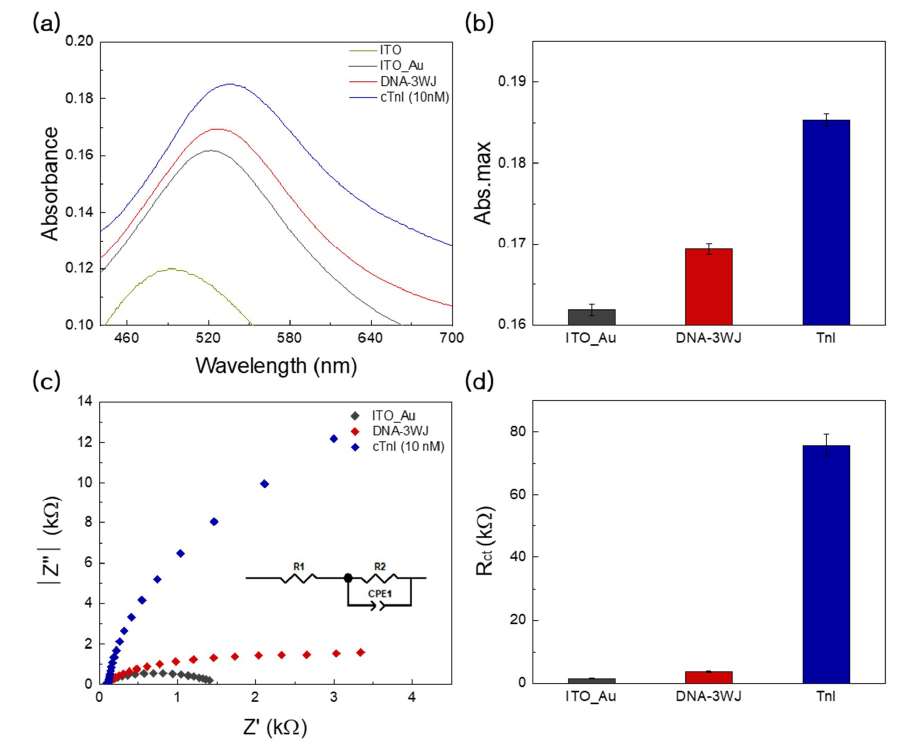
Figure 3. ( a ) Optical characteristics wavelength between 440 to 680 nm of the cTnI / DNA 3WJ / AuNC on ITO substrate (black line), DNA 3WJ layer (red line), cTnI reacted with DNA 3WJ (blue line), respectively. ( b ) Change in absorbance peak based on immobilization of AuNC, DNA 3WJ, cTnI protein layers, respectively. ( c ) Electrochemical impedance spectra of cTnI / DNA 3WJ / AuNC on ITO substrate (black line), DNA 3WJ layer rRed line), cTnI reacted with DNA 3WJ (blue line), respectively. ( d ) Change in R 2 immobilization of AuNC, DNA 3WJ, cTnI protein layers, respectively.